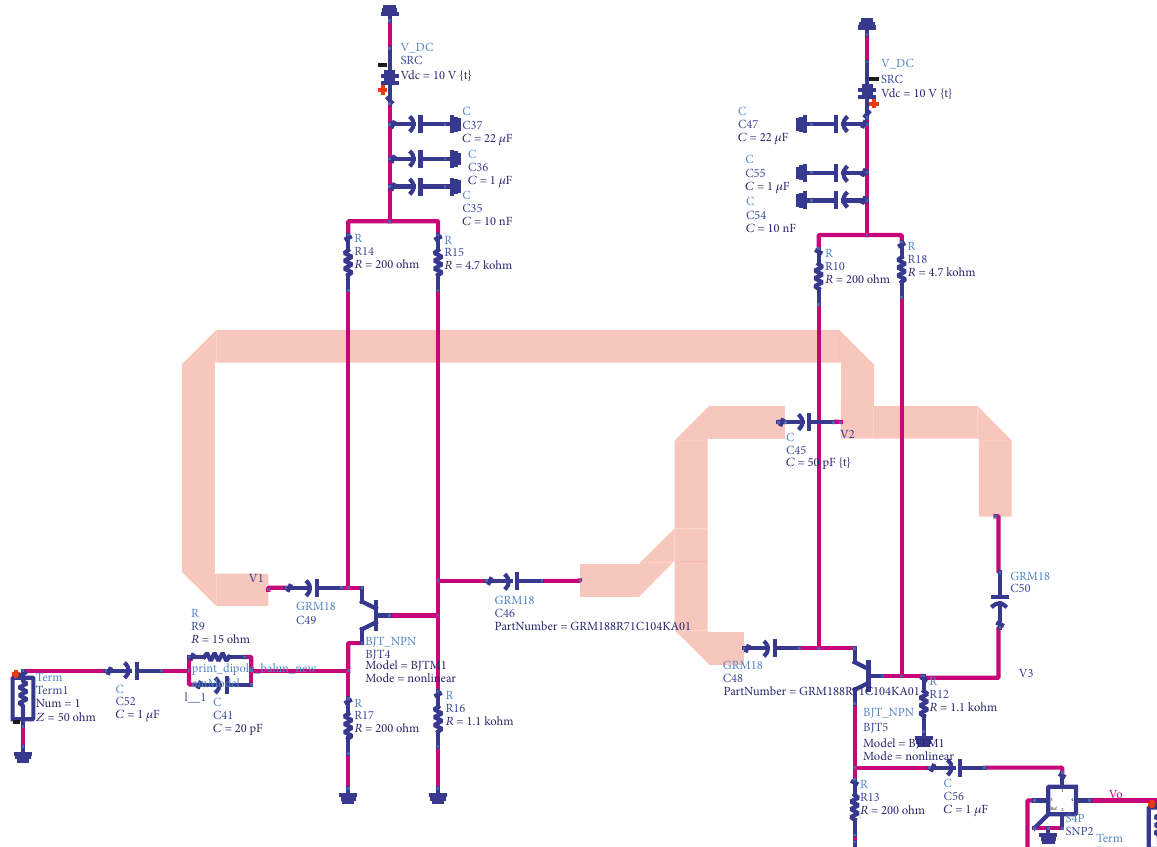
Figure 7: Cosimulation schematic of the NIC, where TLBLCs of the signal path are the EM model and other components are the lumped